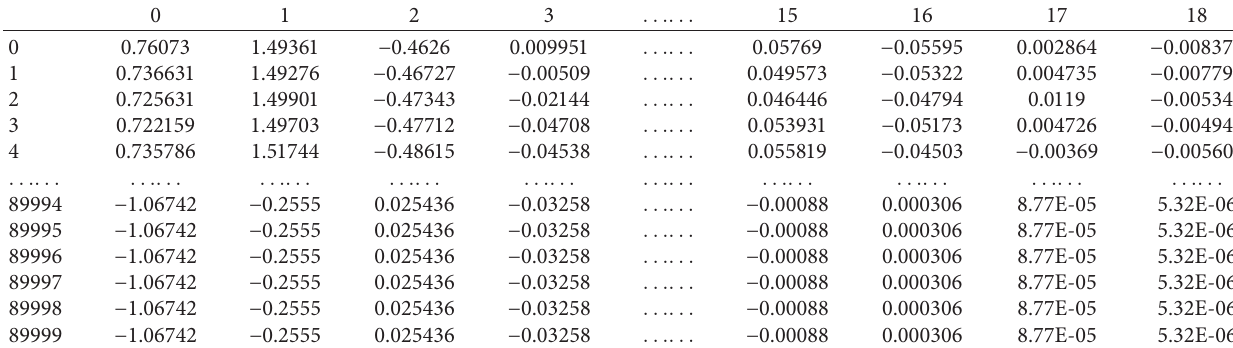
Table 4: KDD CUP 99 dataset PCA processing.